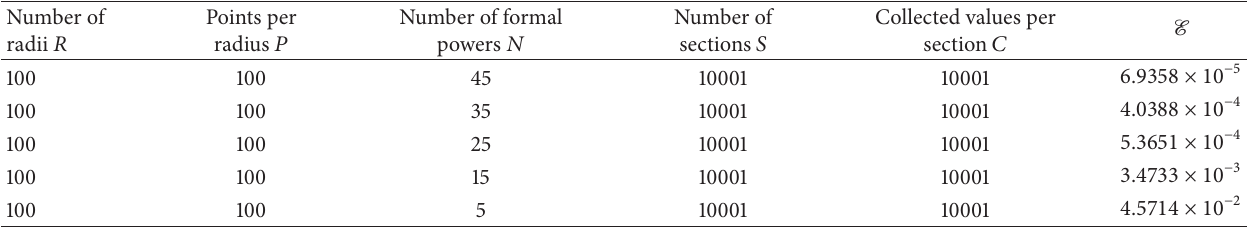
Table 5: Relation between the error E and the number of sections 𝑆 and samples per section 𝐶 , when 𝜎 = (𝑥 2 + 0.1) Number of radii 𝑅